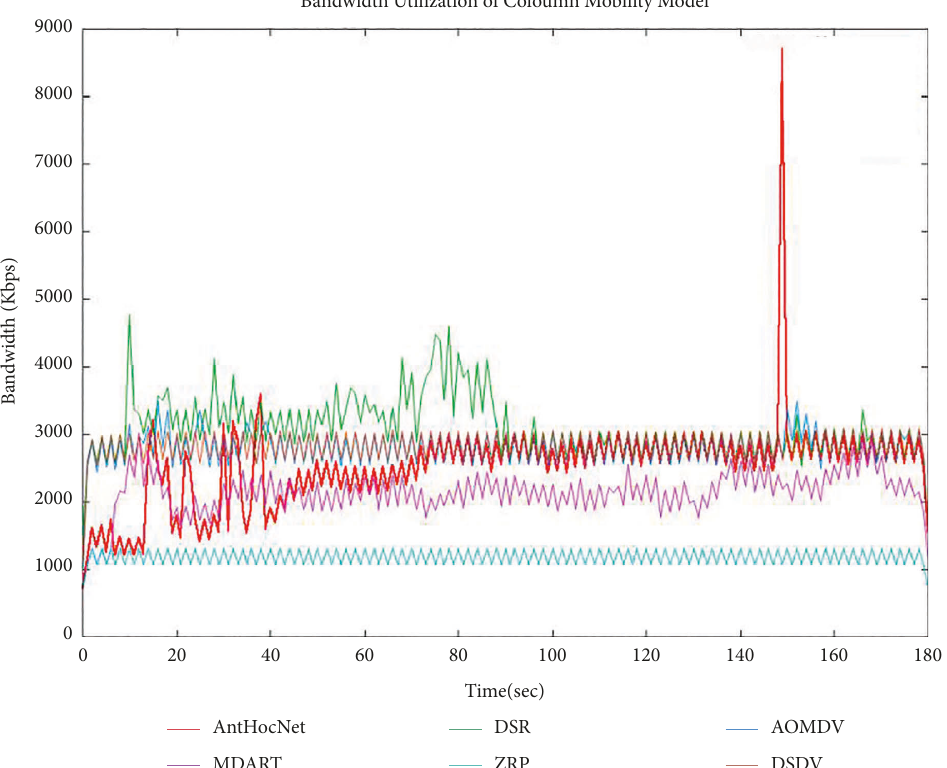
Figure 6: Bandwidth utilization for column mobility using AntHocNet, DSR, AOMDV, M-DART, ZRP, and